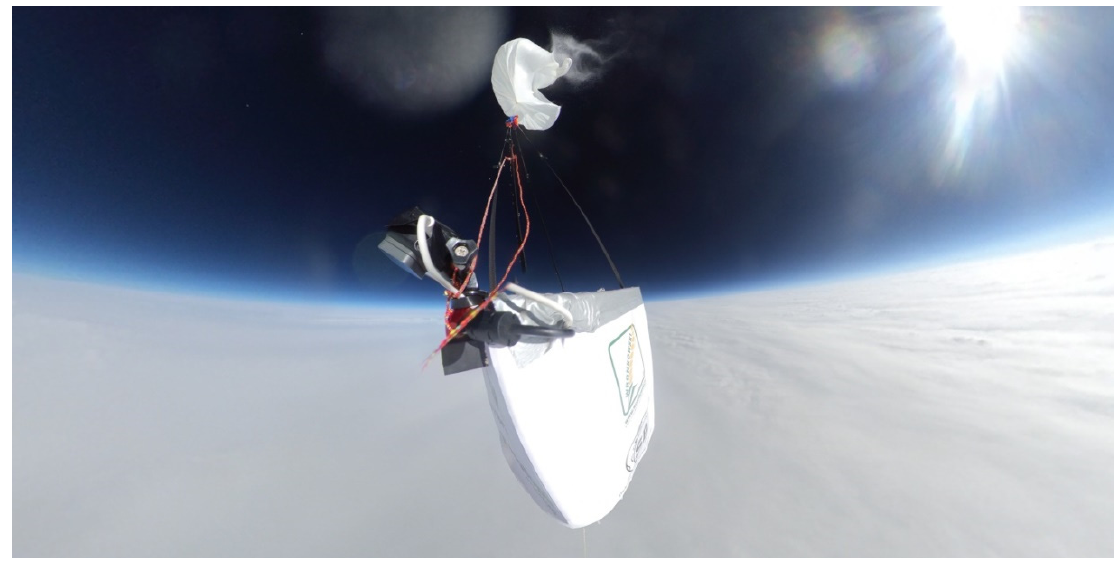
Figure 20. The schematic of the balloon mission’s trajectory through the storm front.